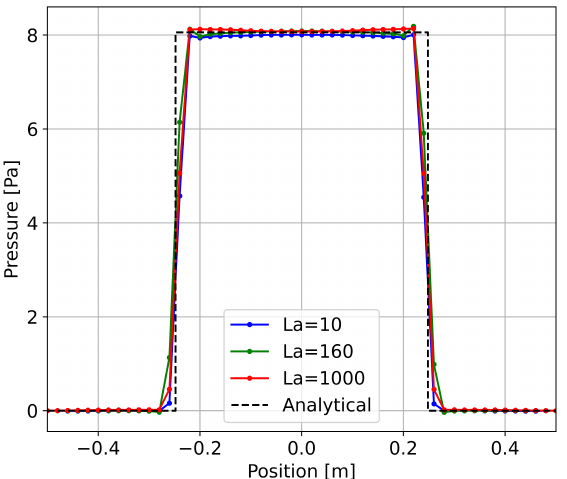
Figure 5. Time evolution of the pressure difference between fluid phases.